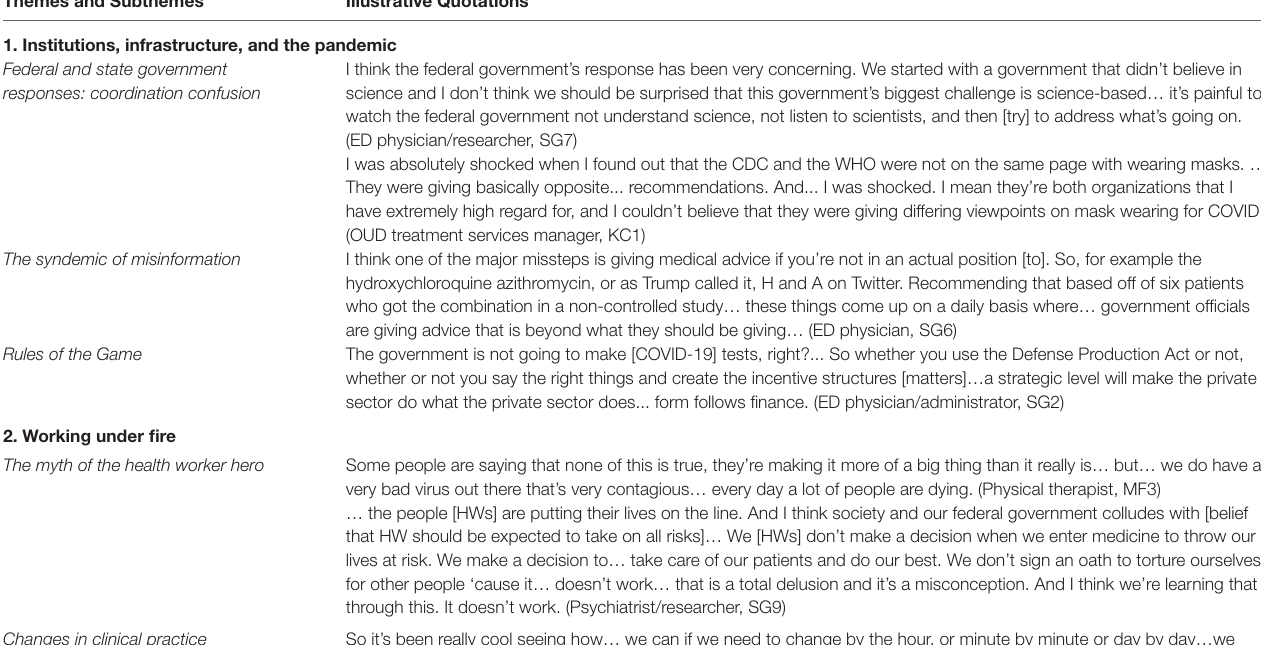
TABLE 2 | Selected supplementary illustrative